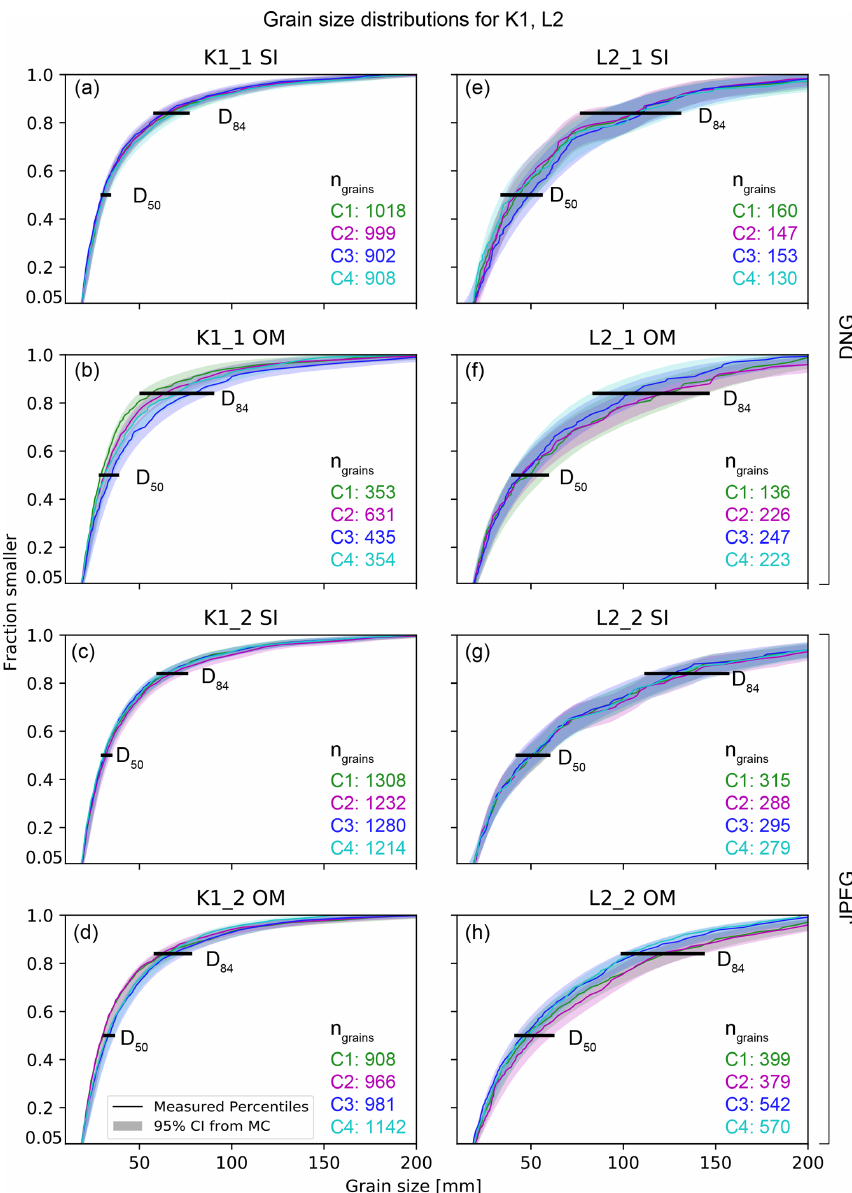
Figure 5. Selected grain size (i.e., b -axis length) distributions measured in different images (SI: single image; OM: orthophoto mosaic) from various UAV models (see Fig. 2 for model characteristics and color legend) with the modeled 95% confidence interval (CI) for each percentile. All Kander (K1) data (a–d) in this figure refer to region A, while all Luetschine (L2) data (e–h) correspond to the respective region A (see Fig. 1 for location). DNG: raw image acquisition format; JPEG: JPEG image acquisition format; D 50 , D 84 : percentiles 50 and 84, respectively; n grains : number of segmented